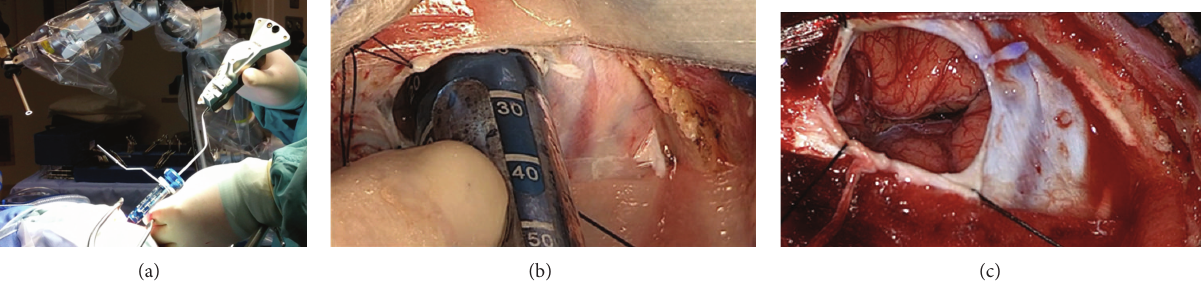
Figure 1: Intraoperative images depicting (a) the Mi SPACE computer assisted navigation system and the radial access transsulcal corridor system, BrainPath (BP) (NICO corp., Indianapolis, Indiana), (b) BrainPath (BP), and (c) the small craniotomy site and dime-sized dural opening created along the predefined sulcus for an entry point. A narrow dural opening allows for a tight seal against the edges of the